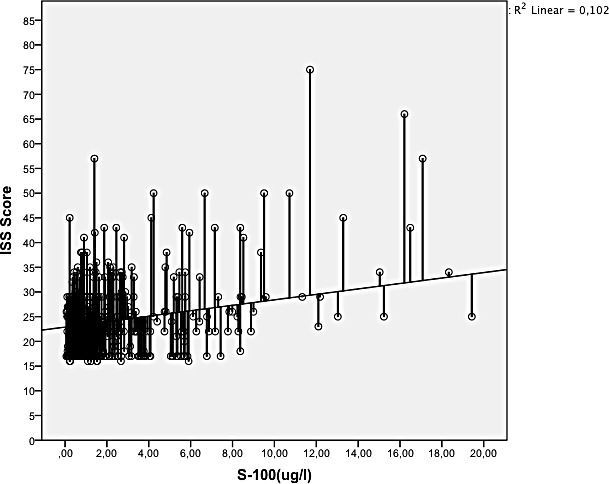
Correlation between S-100 B concentration and ISS (0.0001).